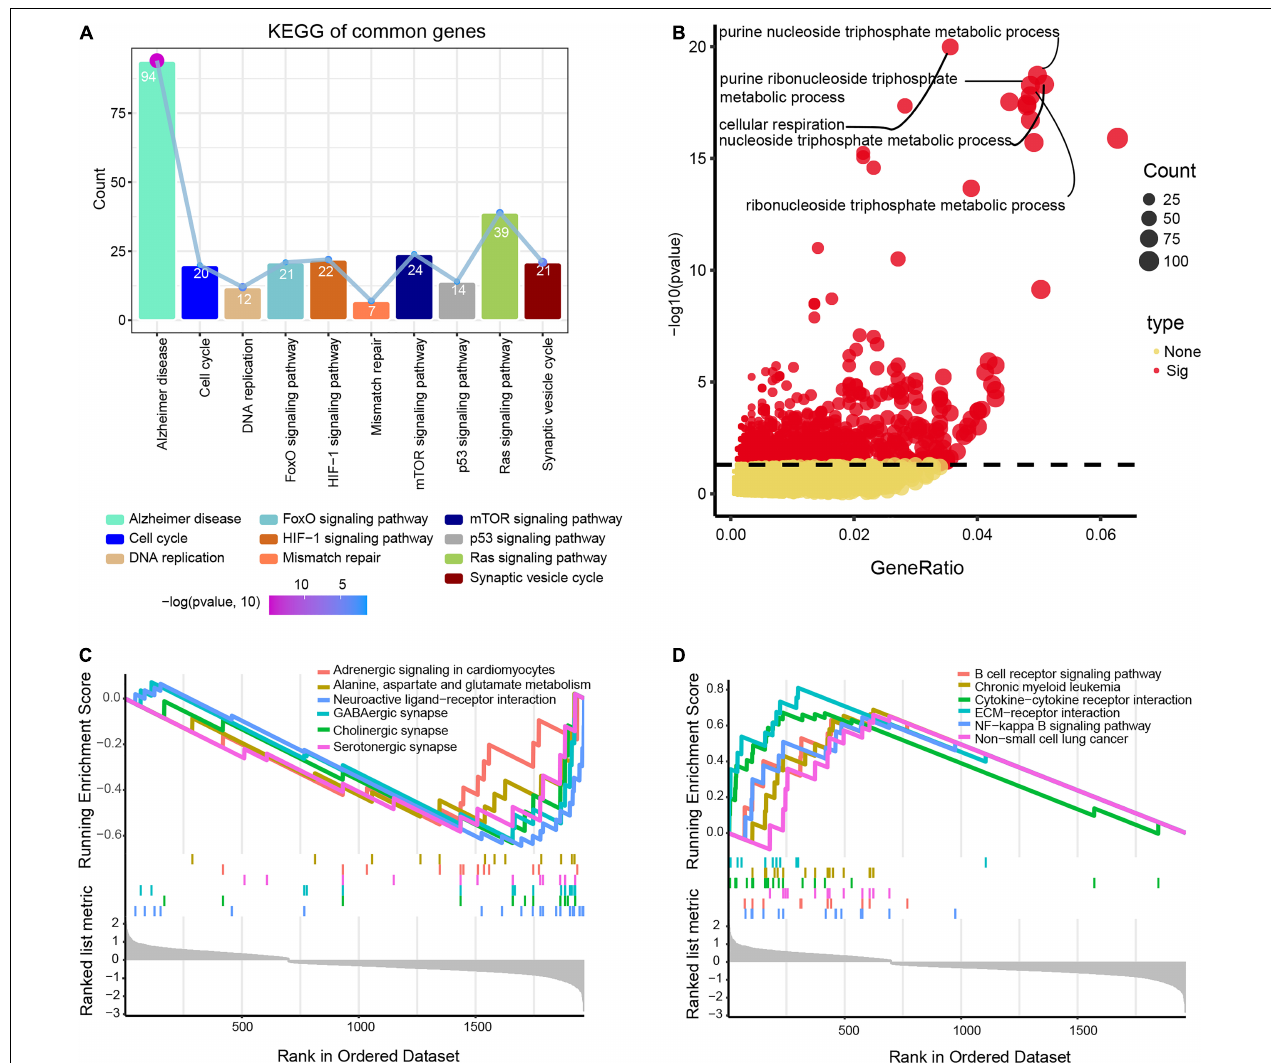
FIGURE 3 | Potential functions of differentially expressed genes in Alzheimer’s disease (AD) and vascular dementia (VD). (A) Enrichment of genes in Kyoto Encyclopedia of Genes and Genomes (KEGG) pathways. (B) Enrichment of genes in Gene Ontology biological processes. (C, D) Lists of the top six pathways that the genes were predicted to (C) activate or (D) inhibit, based on gene set enrichment analysis. Enriched genes were defined as genes strongly expressed in AD/VD tissues that showed high enrichment scores.